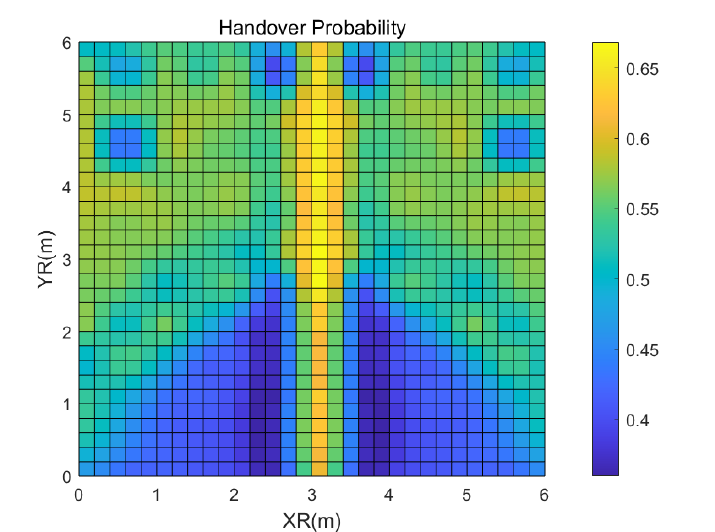
Figure 8. The handover probability for movement under every initial position.